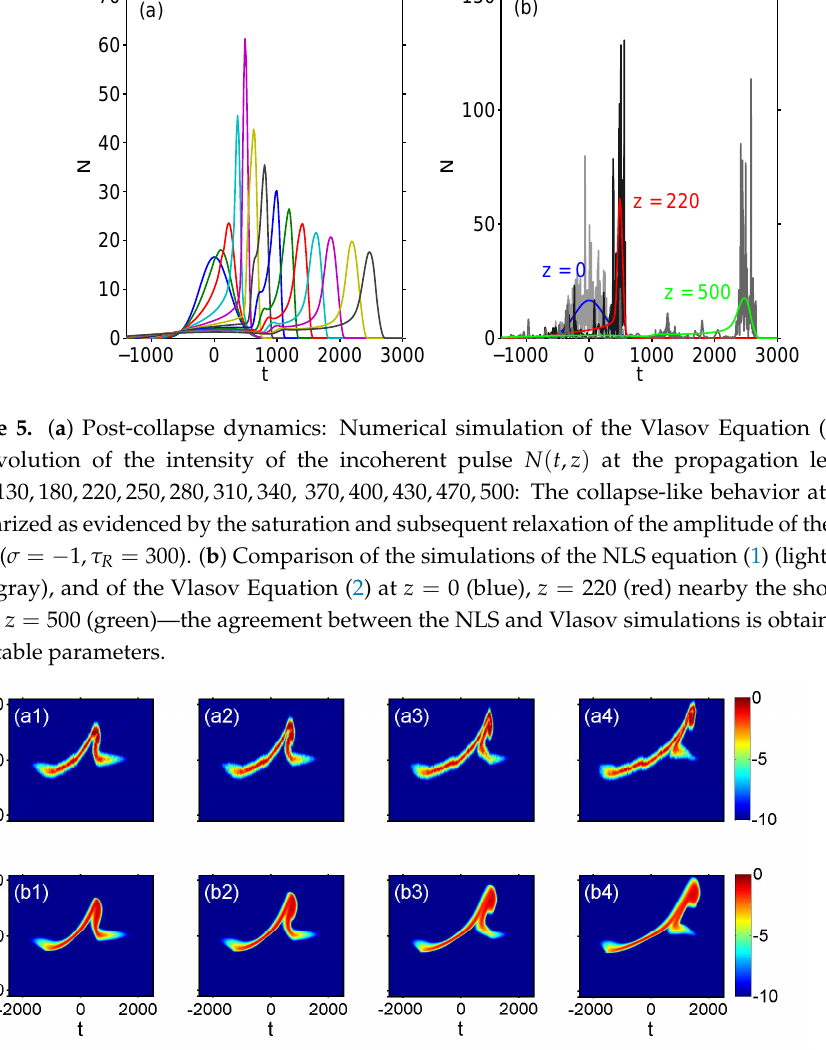
Figure 6. Phase-space representation of the post-shock-collapse singularity shown in Figure 2: ( a ) Numerical simulation of the NLS Equation (1) showing the evolution of the spectrogram. ( b ) Numerical simulation of the Vlasov Equation (2) showing the evolution of n ω ( t , z ) . The agreement between the NLS and Vlasov simulations is obtained without adjustable parameters. Parameters are: σ = − 1, τ R = 300, with the propagation lengths z = 240,270,320,380 from left to